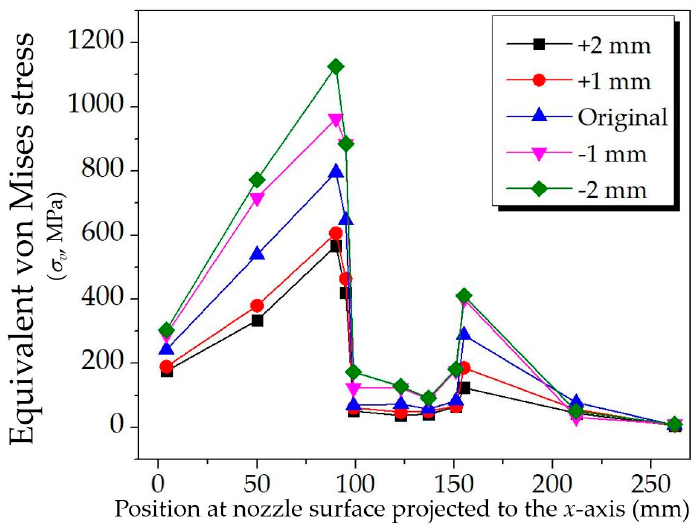
Figure 20. Effect of insulators’ thickness on the equivalent von Mises stress.